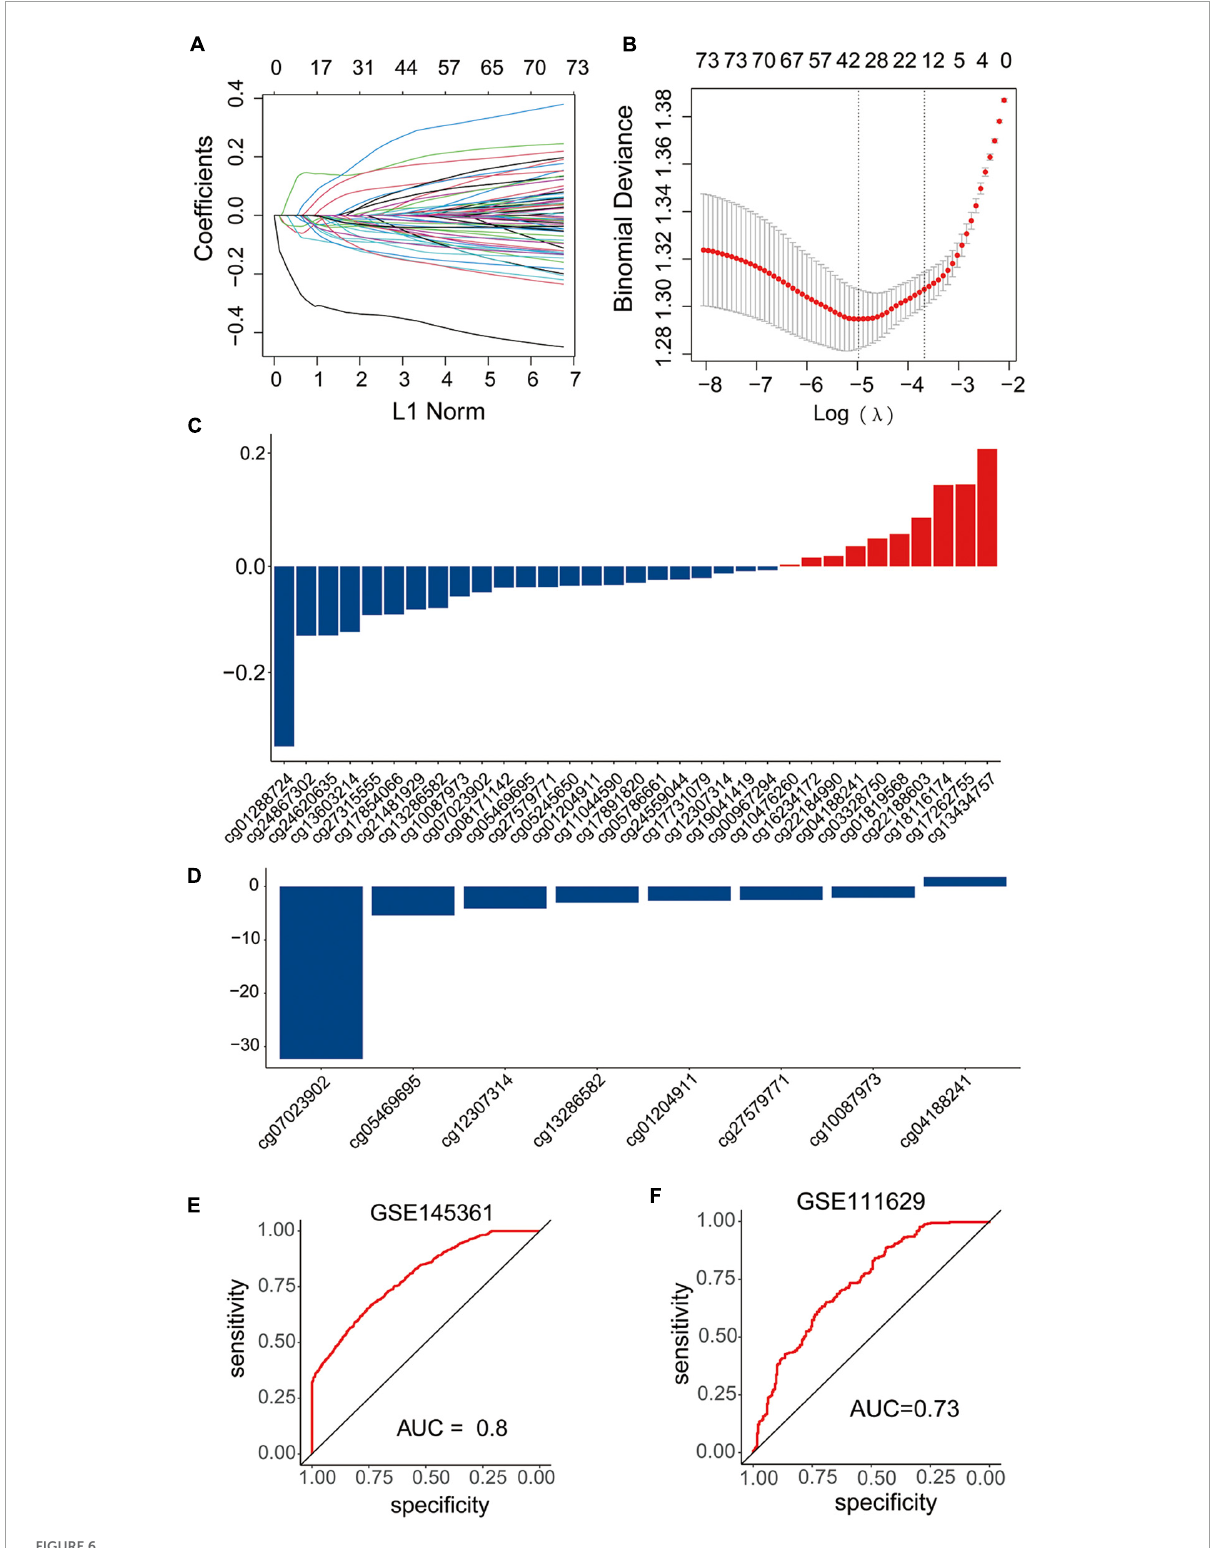
FIGURE6 Construction and validation of the diagnostic signature based on DNA methylation sites. (A–C) LASSO regression was performed to calculate the (A,B) minimum criteria and (C) coefficients. (D) Coefficients of eight DNA methylation sites in the signature selected by the stepwise logistic regression analysis. (E,F) ROC curves of the signature in the training set GSE145361 and testing set